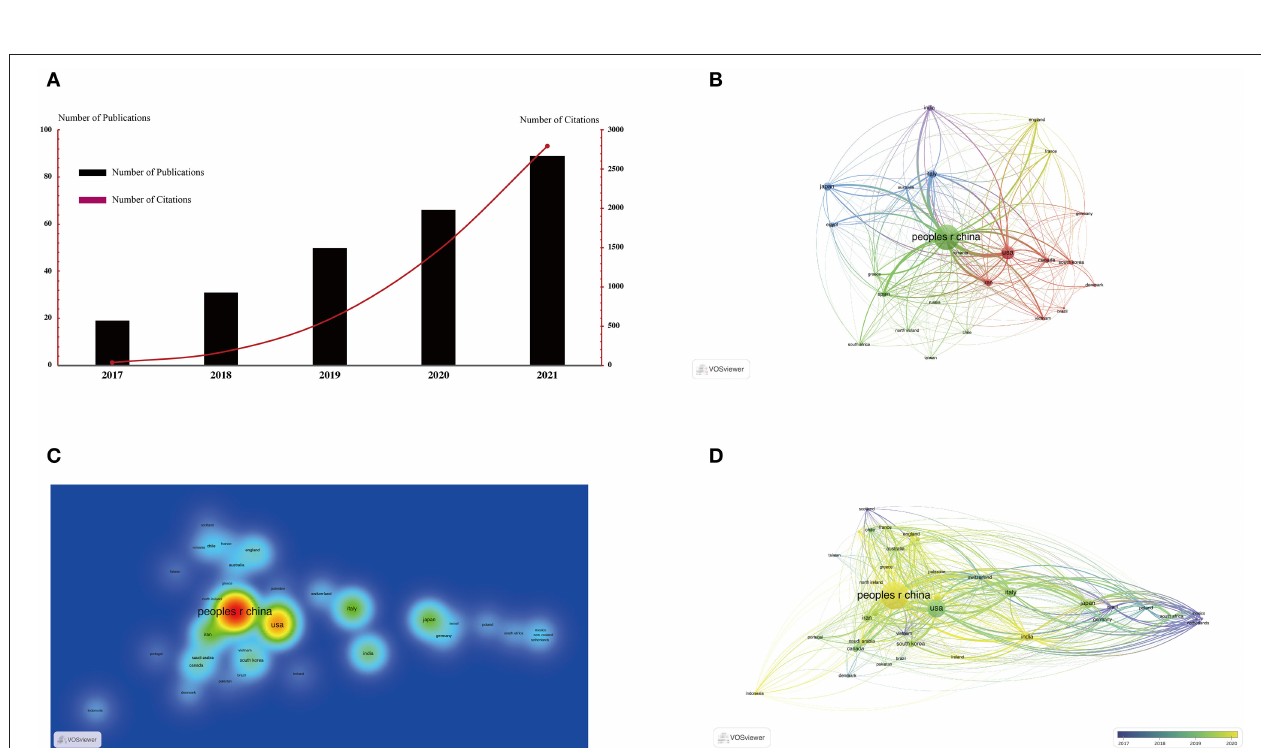
FIGURE 2 | Articles related to SC-EVs for diabetes published worldwide. (A) Annual publications and citations worldwide of SC-EVs for diabetes. (B) Network visualization of the country distribution of articles based on VOSviewer. The size of the circles signifies the number of publications, and the width of the connecting line between the two circles signifies the intensity of collaboration. (C) Density map of the country distribution of articles based on VOSviewer. (D) Chronological order of countries based on VOSviewer.